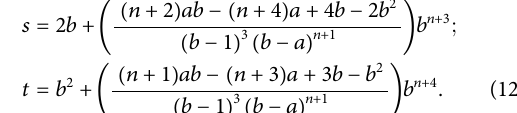
FIGURE 1 Schematic zoomed-in diagram of a spinodal curve (black colored) and three isobar curves (blue colored). There are two adjacent critical points on a spinodal curve at v r = a and at v r = 1. When P r < 1,theisobarcrossesthespinodalcurvetwiceat v r < a and at v r > 1. When P r > 1, the isobar does not meet the spinodal curve. When P r = 1, with negligible ϵ , the critical isobar touches the spinodal curve at the two critical points. Speci fi cally, along the critical isobar, as the temperature increases from T r < 1 to T r = 1 − , the critical point at v r = a with the critical index of n c = n = 2, 4, 6 is relevant. On the other hand, as the temperature decreases from T r > 1 to T r = 1 + , the dominant critical point is at v r = 1 with n c = 2. Between the two peaks on the spinodal curve, there is a local minimumwhichmaybealsoidenti fi edasa “ criticalpoint ” ofwhich the critical temperature is less than T c . This third critical point is sandwichedbythetwoextremelyadjacentcriticalpointsandplays an inconsiderable role in our analysis. The diagram generalizes the single-peaked spinodal curve of a relativistic ideal Bose gas, depicted in Figure 1 of Ref. [8], to twin-peaks, and furthermore will be con fi rmed through a concrete example as in Figure 2.